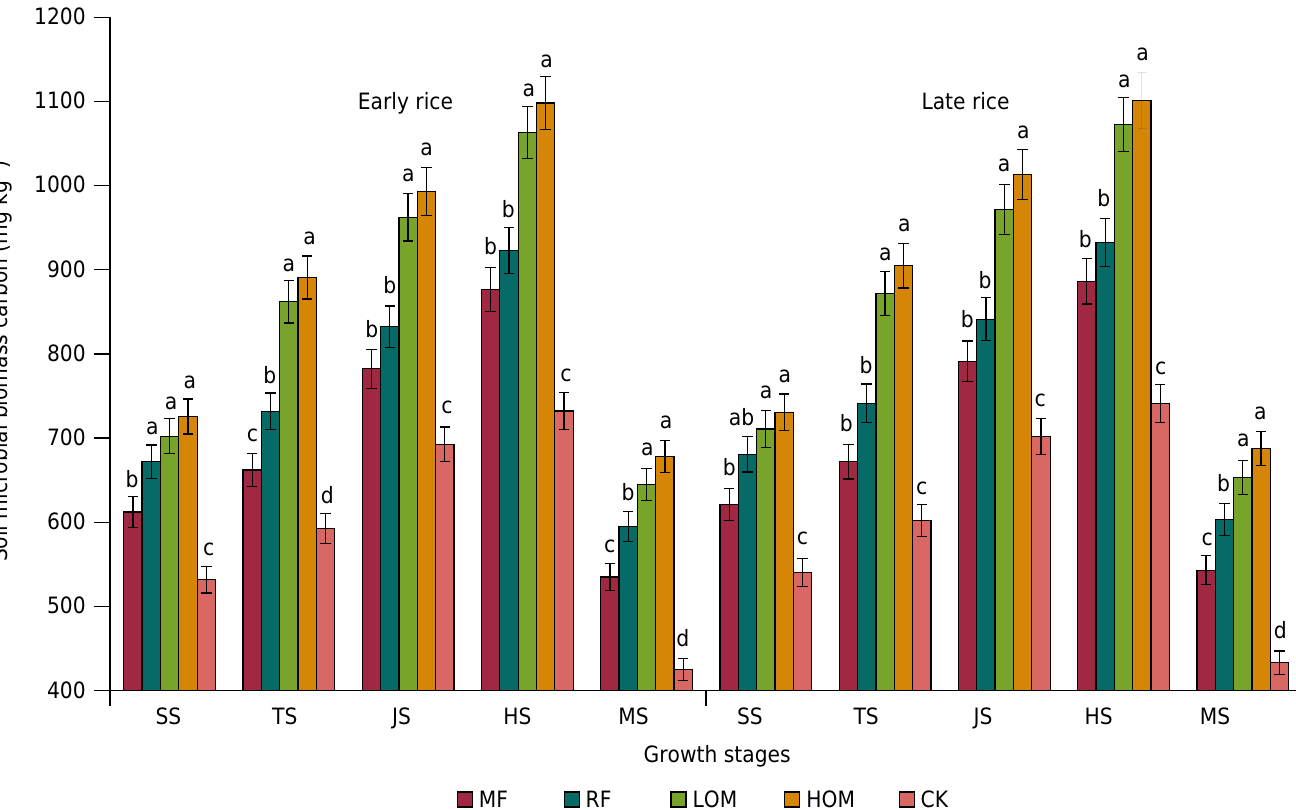
Figure 2. Effects of different long-term fertilization treatments on soil microbial biomass carbon in a paddy field at main rice growth stages. MF = mineral fertilizer alone; RF = rice straw residues and mineral fertilizer; LOM = 30 % organic matter and 70 % mineral fertilizer; HOM = 60 % organic matter and 40 % mineral fertilizer; CK = without fertilizer input; SS = seedling stage; TS = tillering stage; JS = jointing stage; HS = heading stage; MS = mature stage. Bars represent standard deviation (SD) of three replicates. Different letters indicate significance at p < 0.05 among the fertilization treatments at the same rice growth stage, according to the least significant difference